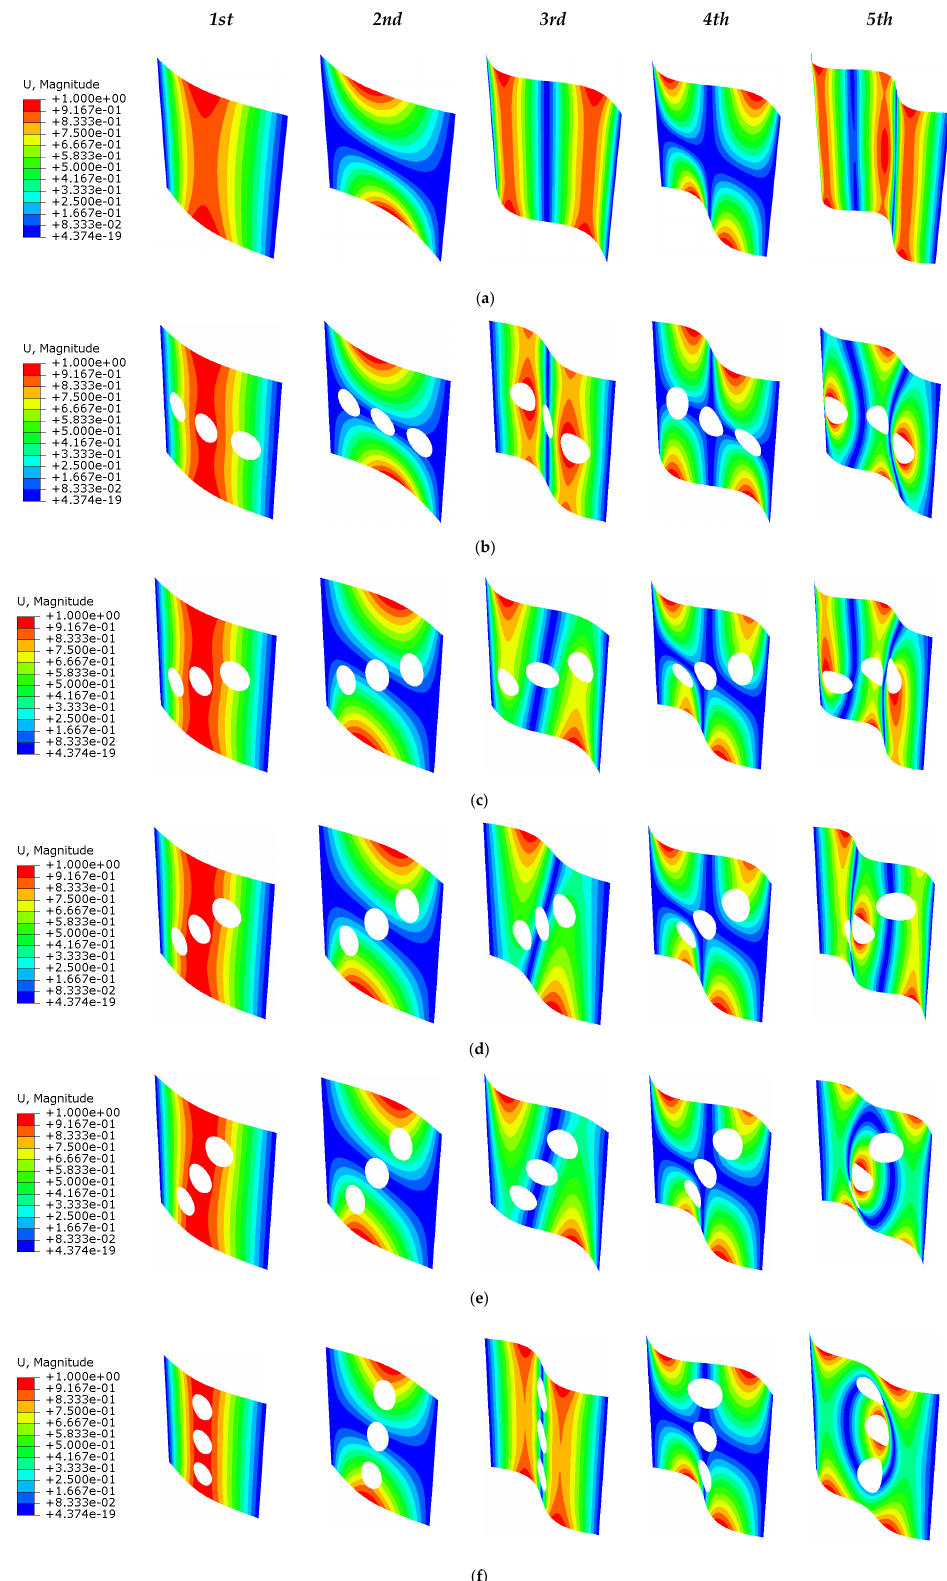
Figure 9. The first five buckling modes of FGM plates with ( a ) a plate thickness of 25 mm, a cutout diameter of 300 mm, and an arrangement of ( b ) 0 ° , ( c ) 30 ° , ( d ) 45 ° , ( e ) 60 °, and ( f ) 90 °.